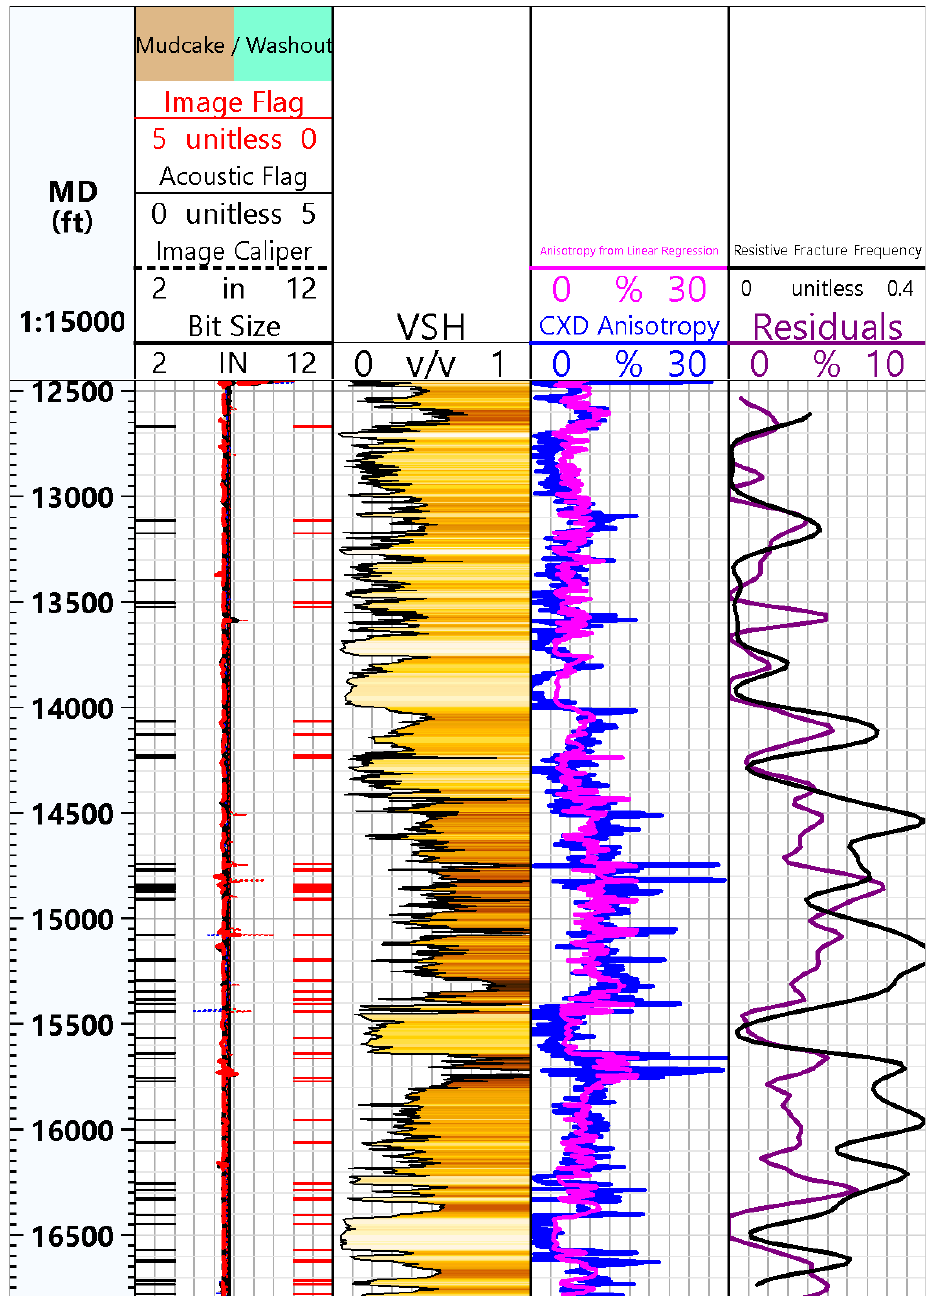
Figure 9. Plot showing a strong correlation in the first well between the cross-dipole sonic anisotropy (CXD) and the anisotropy predicted using Equation (2), and a strong correlation between the